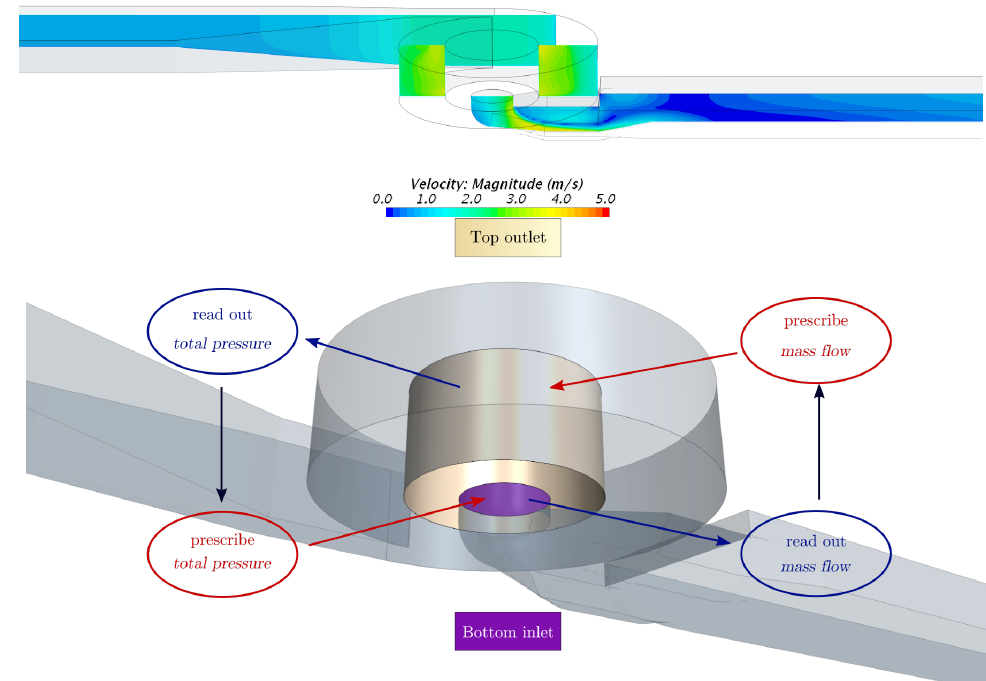
Figure 4. Main features of a simplified simulation for the WVPP , based on the family of simulations depicted in Figure 3, but with much of the sophistication removed. ( Top ): a cross-section of the weir is shown, with plane sections colored according to velocity. ( Bottom ): coupling mechanism between the upper and lower parts of the weir, seen from below the turbine